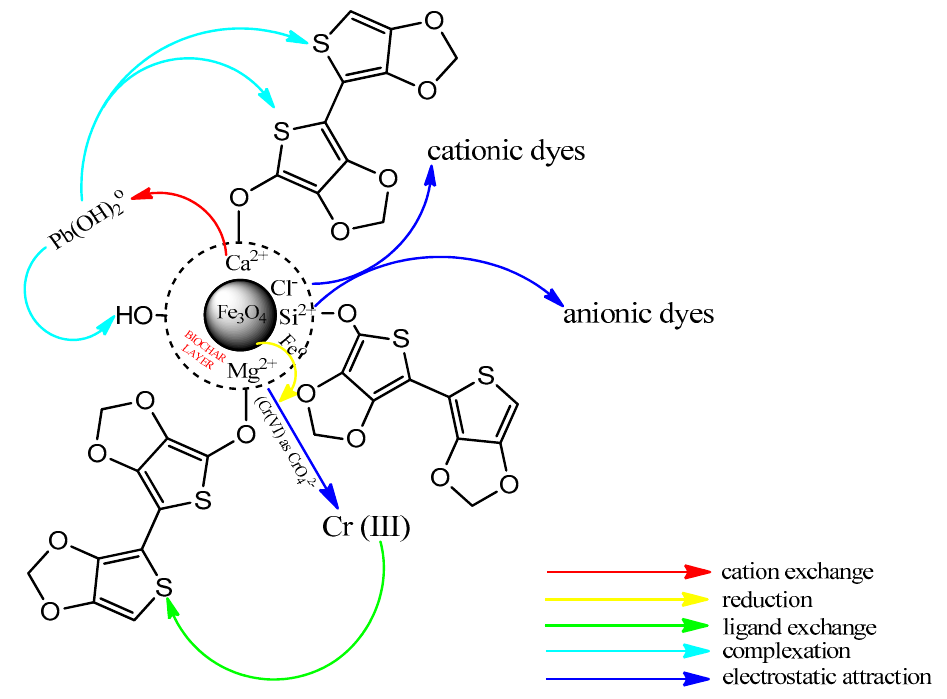
Figure 5. Proposed mechanism for the removal of some pollutants on a biochar-capped and poly(3,4-